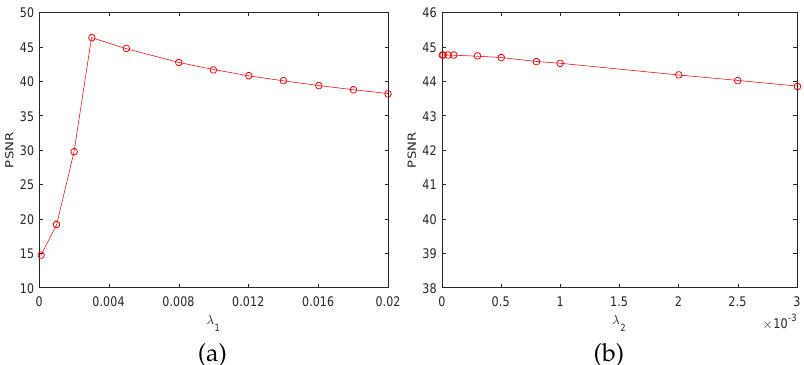
Figure 19. The PSNR curves as function of the regularization parameters. ( a ) The relationship between PSNR and the parameter λ 1 (with λ 2 = 10 − 5 , τ 1 = 0.1, τ 2 = 0.01); ( b ) the relationship between PSNR and the parameter λ 2 (with λ 1 = 0.005, τ 1 = 0.1, τ 2 = 0.01).